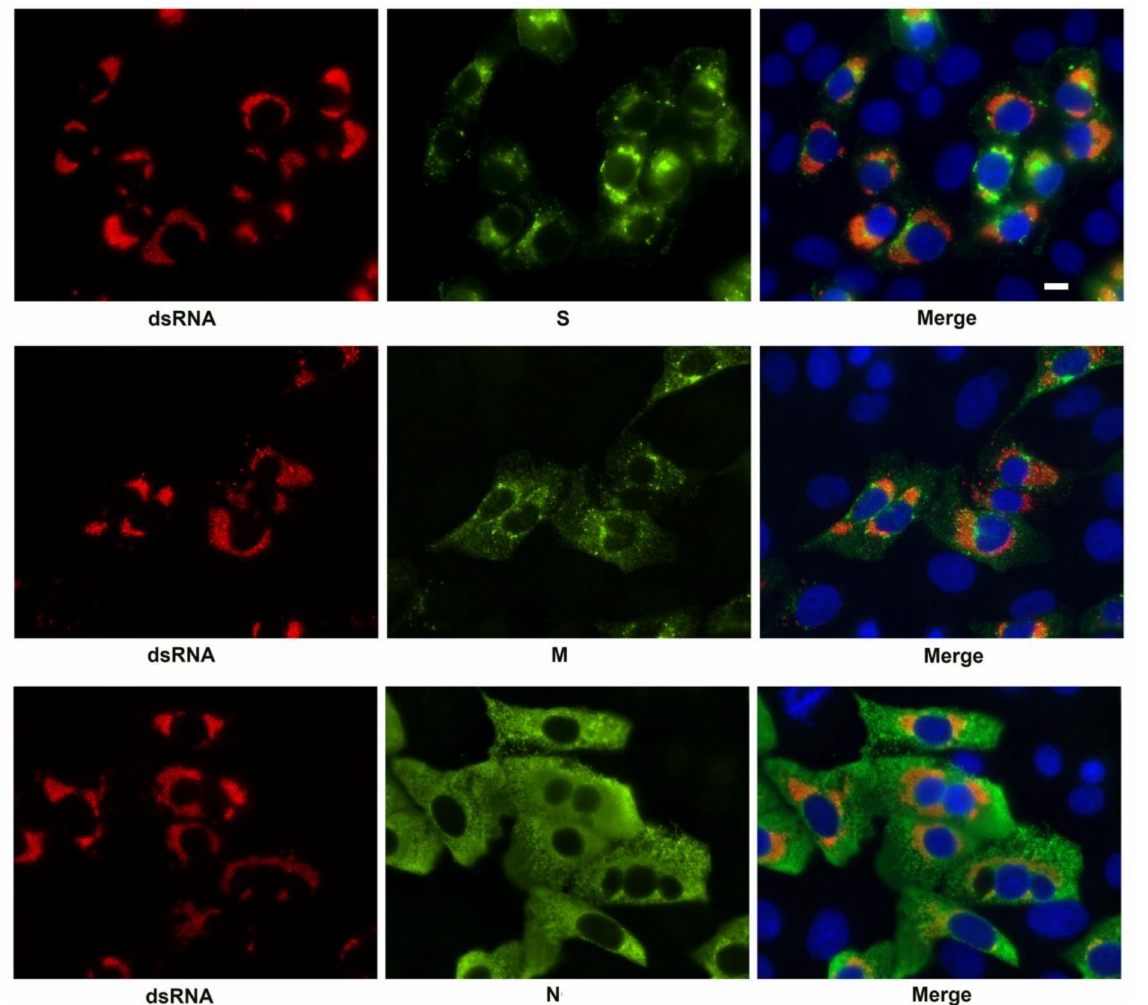
Figure 4. Immunofluorescent labeling of the SARS-CoV-2 replication complex at 24 h post-infection by antibody detecting dsRNA (red). Viral antigens S, M, and N, are shown in green. The merged image is counterstained with DAPI (blue). Bar = 10 µ